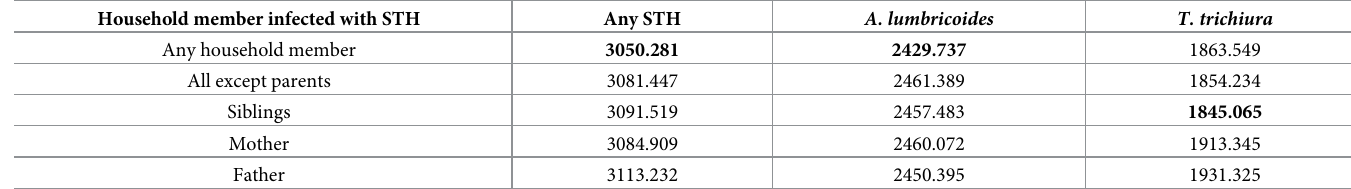
Table 2. Soil-transmitted helminth infections (STH) among household members showing best age-adjusted model fitted by generalized estimating equation models and using quasi-likelihood under the independence model criterion (QIC). Household member infected with